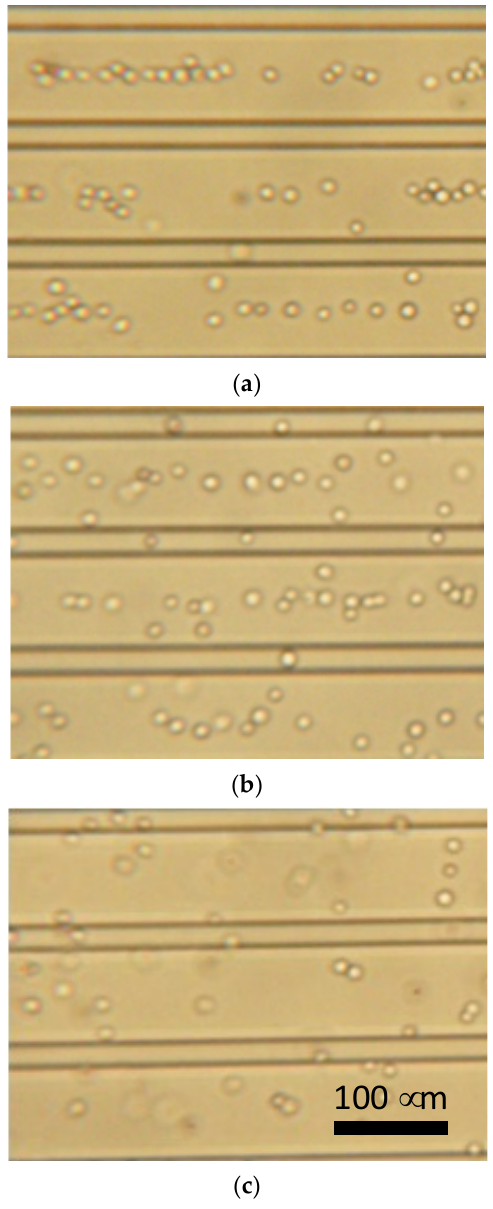
Figure 7. Dielectrophoresis of chondrocytes using parallel line-electrode array. ( a ) 10 kHz, ( b ) 100 kHz, and (c) 500 kHz of AC voltage.